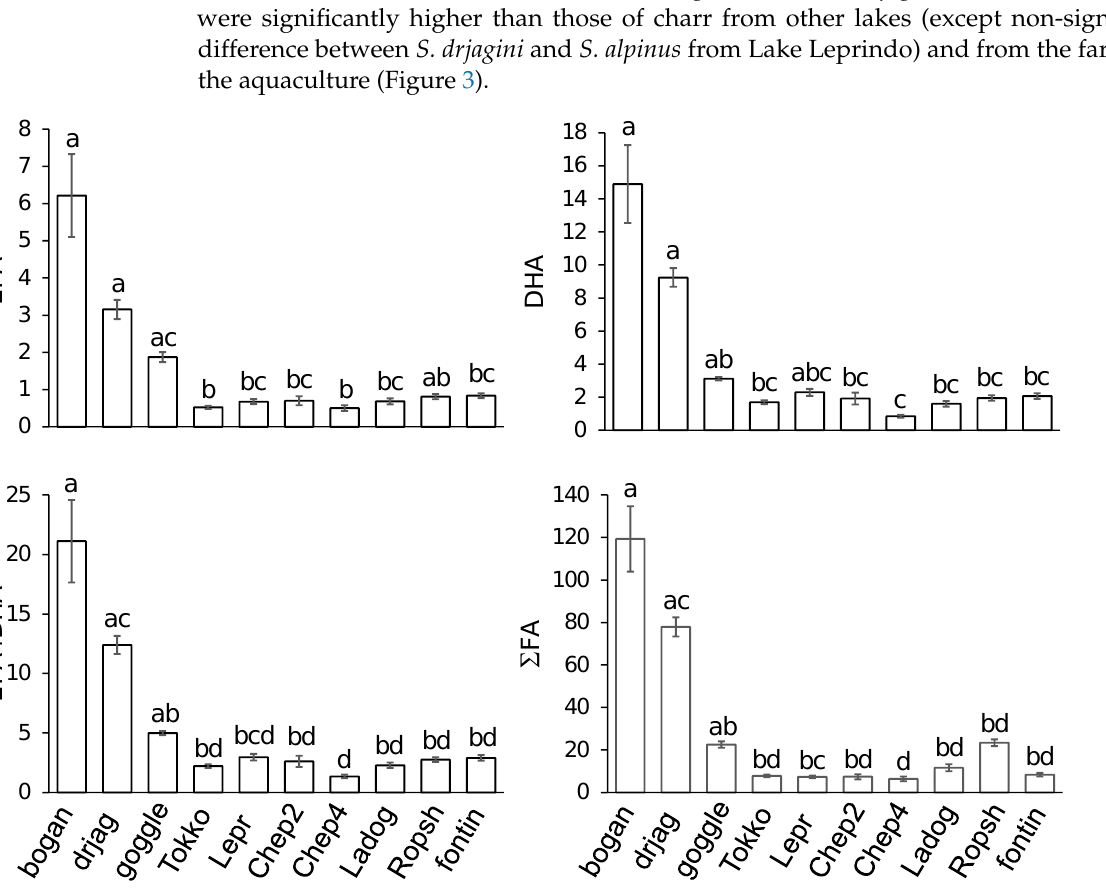
Figure 3. Mean values of contents (mg · g − 1 WW) of eicosapentaenoic (EPA) and docosahexaenoic (DHA) fatty acids and their sum (EPA+DHA), and sum of total fatty acids ( ∑ FA) in muscle tissue of studied fish: boganid charr Salvelinus boganidae (bogan. number of samples, n = 14), Dryagin’s charr Salvelinus drjagini (drjag, n = 16), goggle-eyed charr ( Salvelinus alpinus complex) (goggle, n = 8), all from Lake Sobachye, Arctic charr Salvelinus alpinus from Lake Tokko (Tokko, n = 14), Lake Leprindo (Lepr, n = 7), Lake Chepa-2 (Chep2, n = 6), Lake Chepa-4 (Chep4, n = 7), Lake Ladoga (Ladog, n = 6) and Ropsha farm (Ropsh, n = 7), and brook trout Salvelinus fontinalis from the aquaculture of Timiryazev Academy (fontin, n = 15). Means labelled with the same letter are not significantly different at p < 0.05 according to Kruskal – Wallis test. Bars represent standard errors.